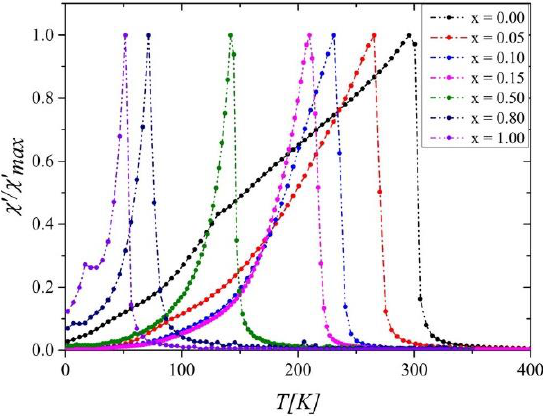
Figure 4. The real part of the AC magnetic susceptibility  ’ normalized against the maximum value of  ’ max for the Gd 0 . 4 Tb 0 . 6 (Co 1-x Ni x ) 2 . of χ (cid:48) max for the Gd 0.4 Tb 0.6 (Co 1 − x Ni x ) 2